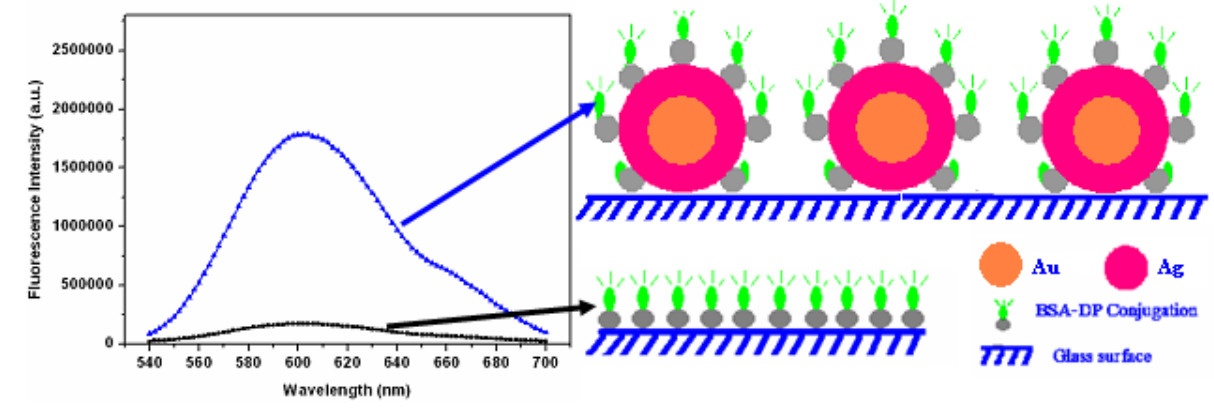
Figure 4. Illustration of metal induced fluorescence enhancement on glass